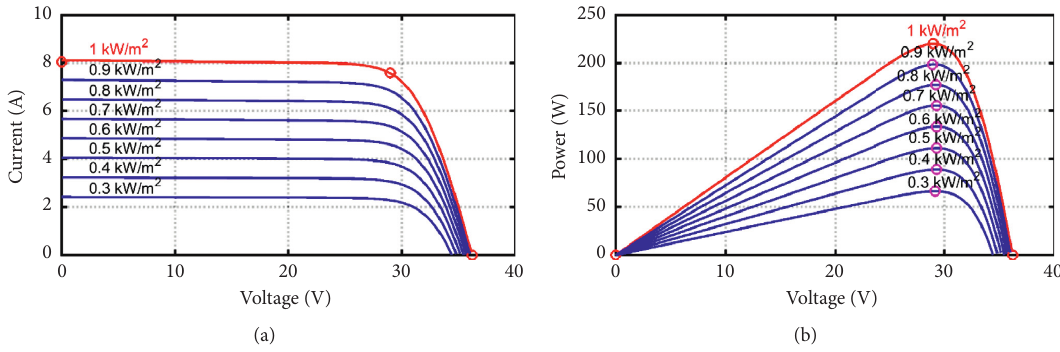
Figure 7: Characteristics of used PV panel at 25 ° C for different irradiances. (a) I–V curves. (b) P–V